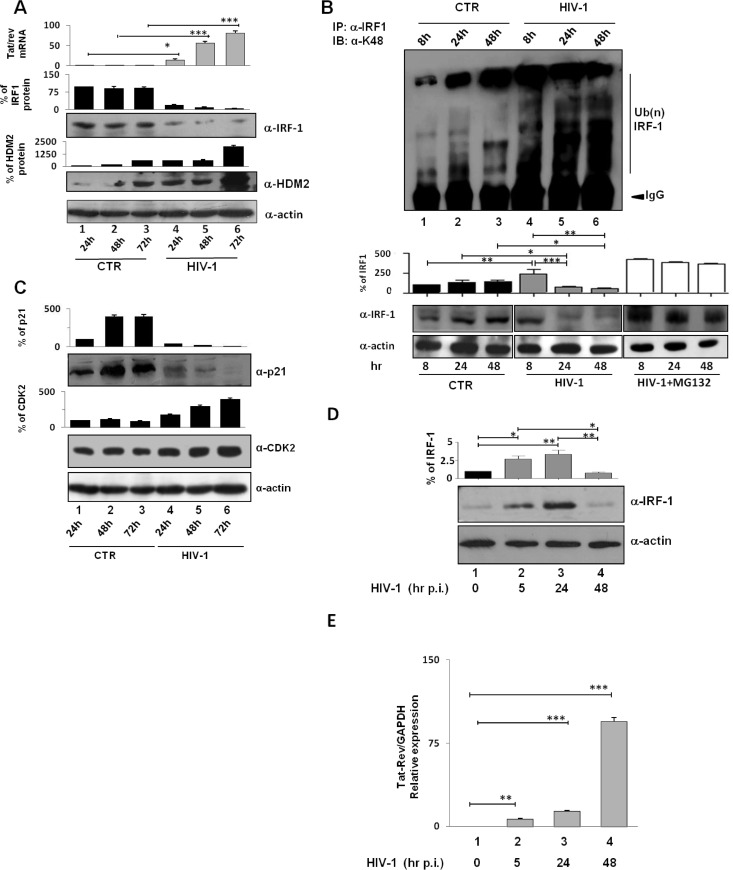
IRF-1 is downregulated and K48 polyubiquitinated in HIV-1-infected Jurkat T cells and during HIV-1 de novo infection of human primary CD4+ T cells when Tat is maximally expressed. (A, top) Tat/Rev RNA levels were measured by real-time RT-PCR as described in Materials and Methods. Means plus SD from three separate experiments calculated after normalization with GAPDH are shown (*, P < 0.05; ***, P < 0.001). (Bottom) WCE were prepared at the indicated time points from infected and uninfected Jurkat cells and then probed with anti-IRF-1, anti-HDM2, and anti-actin antibodies, respectively. Representative Western blots are shown. Data plotted in the graphs represent the means ± SEM from three different assays of IRF-1 and HDM2 protein bands quantified from Western blots and normalized to actin protein levels as the loading control (CTR). Results are presented as percentage values relative to basal IRF-1 and HDM2 expression set at 100. (B) WCE were prepared at the indicated time points from control and HIV-1-infected cells and immunoprecipitated with anti-IRF-1 antibody. IRF-1 ubiquitinated forms were detected using anti-K48 ubiquitin antibody (α-K48). The Western blot is representative of at least three independent experiments with similar results. (Bottom) The levels of IRF-1 in control cells, HIV-1-infected cells, and HIV-1-infected cells in the presence of MG132 are shown. Data plotted in the graphs are the means plus SD of IRF-1-specific bands quantified from Western blots normalized to actin from three independent experiments (*, P < 0.05; **, P < 0.01; ***, P < 0.001). (C) WCE as in panel A were probed with anti-p21 and anti-CDK2 antibodies, respectively. (Top) Quantification of p21 and CDK2 calculated as in panel A. (Bottom) Representative Western blots. (D) Purified human primary CD4+ T cells were infected with HIV-1 as described in Materials and Methods, and WCE were subjected to Western blot analysis with specific anti-IRF-1 antibody. Data plotted in the graph represent the means plus SD from three independent experiments (*, P < 0.05; **, P < 0.01). The time (in hours postinfection [hr p.i.]) is shown below the blot. (E) Total RNA was extracted at the indicated time points from cells as described above for panel D and analyzed by real-time RT-PCR for the doubly spliced (Tat/Rev) transcript as described in Materials and Methods (**, P < 0.01; ***, P < 0.001).